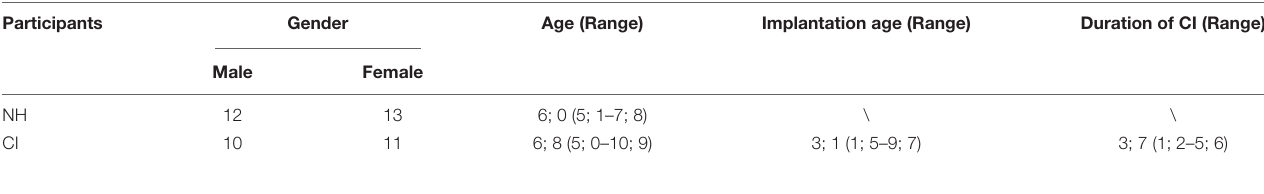
TABLE 1 | Demographic information of